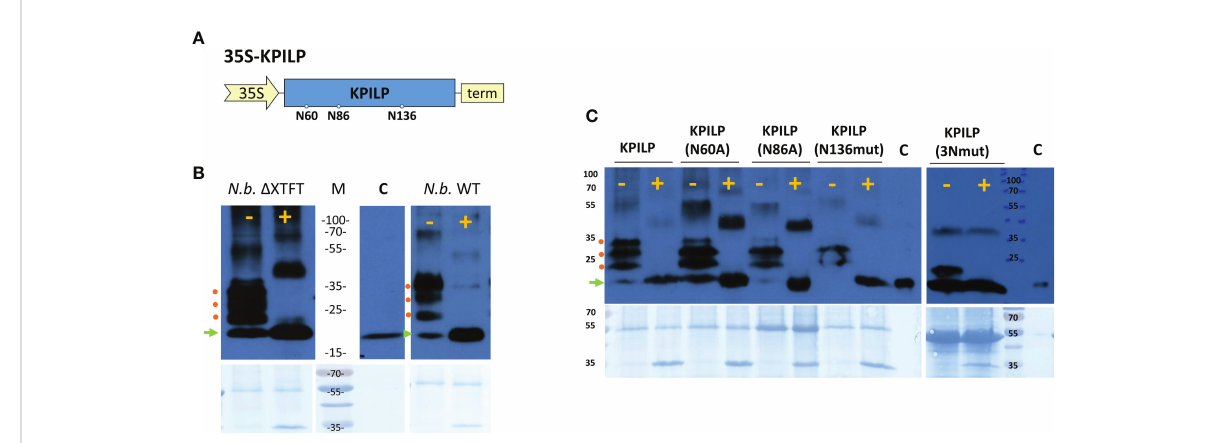
FIGURE 6 KPILP is a glycoprotein containing N-glycosylation sites sensitive to PNGase F treatment. (A) Schematic representation of genetic construct encoding KPILP. Predicted N-glycosylation sites are designated with circles. 35S, Cauli fl ower mosaic virus (CaMV) 35S promoter; term, 35S terminator of transcription. (B) Western blot analysis of KPILP-enriched preparation isolated from the leaves of transgenic D XTFT or wild-type (WT) N. benthamiana plants agroin fi ltrated with 35S-KPILP. Samples treated with PNGase F (+) or without treatment (-) are probed with antibodies against KPILP. The lower panels show the protein loading control stained with Amido black. Protein molecular weight markers are indicated. C (control), recombinant 6×His-KPILP protein produced in E . coli . (C) KPILP-enriched preparation isolated from the leaves of wild- type N. benthamiana plants producing KPILP mutant variants with abolished one of the N-glycosylation sites or all of three of them (3Nmut). Samples treated with PNGase F (+) or without treatment (-) are probed with antibodies against KPILP raised in rabbit and then with anti-rabbit antibodies conjugated with horseradish peroxidase. The lower panels show the protein loading control stained with Amido black. Protein molecular weight markers are indicated. C (control), recombinant 6×His-KPILP protein produced in E . coli . Green arrowhead indicates the position of the non-glycosylated KPILP, red circles – KPILP with one or several N-linked